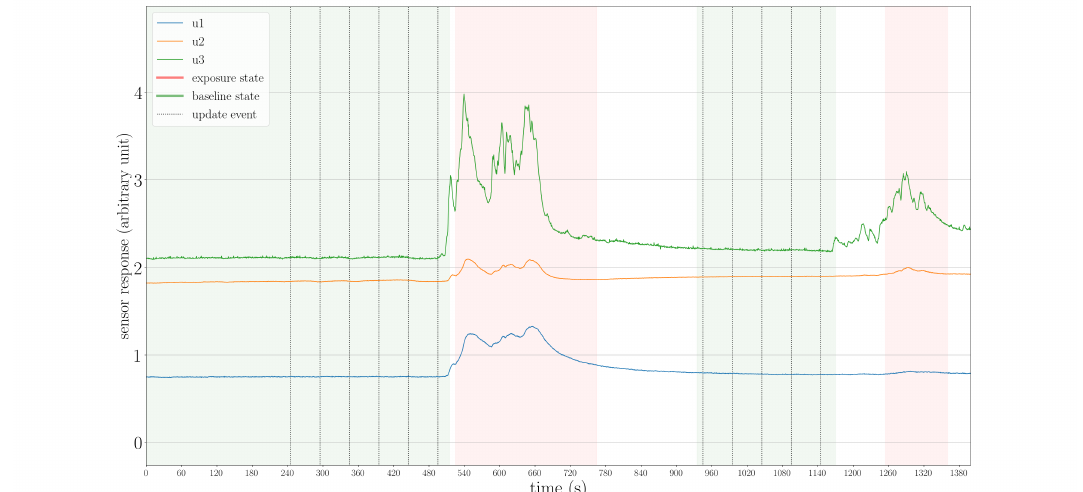
Figure 15. The baseline and exposure states found in Experiment 1. Before the second determined exposure state, some gas detection events are missed by the proposed gas detection